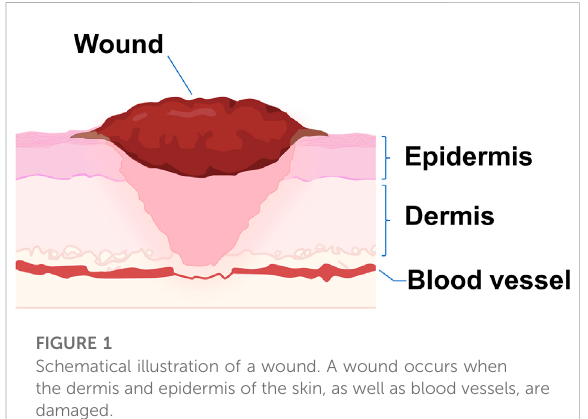
FIGURE 1 Schematical illustration of a wound. A wound occurs when the dermis and epidermis of the skin, as well as blood vessels, are